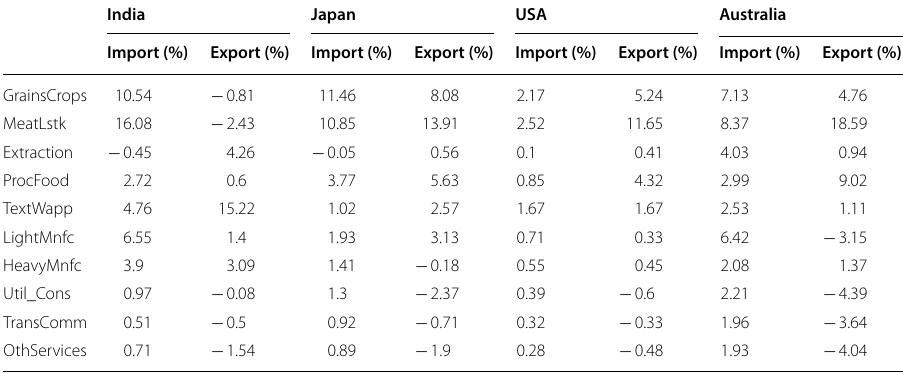
Table 4 Impact of tariff eliminations on sectoral trade under ‘Indo-Pacific 1’. Source: Authors’ simulation from GTAP version